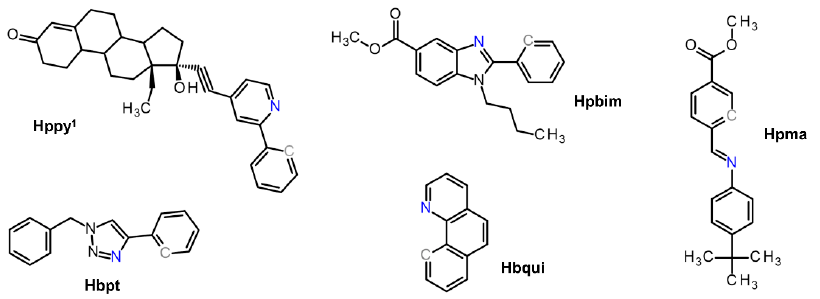
Figure 6. Structural formulas of selected bidentate C , N -donor L^L ligands, with donor atoms given in blue (N) or grey (C). in blue (N) or grey